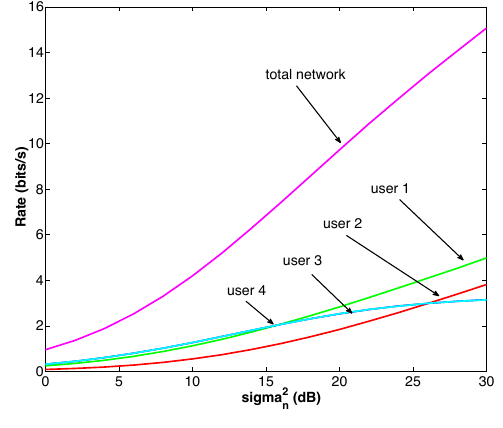
Figure 7. Rate Performance of the network and every user separately (MIMO BC) for 𝑐 = 0 . 0255